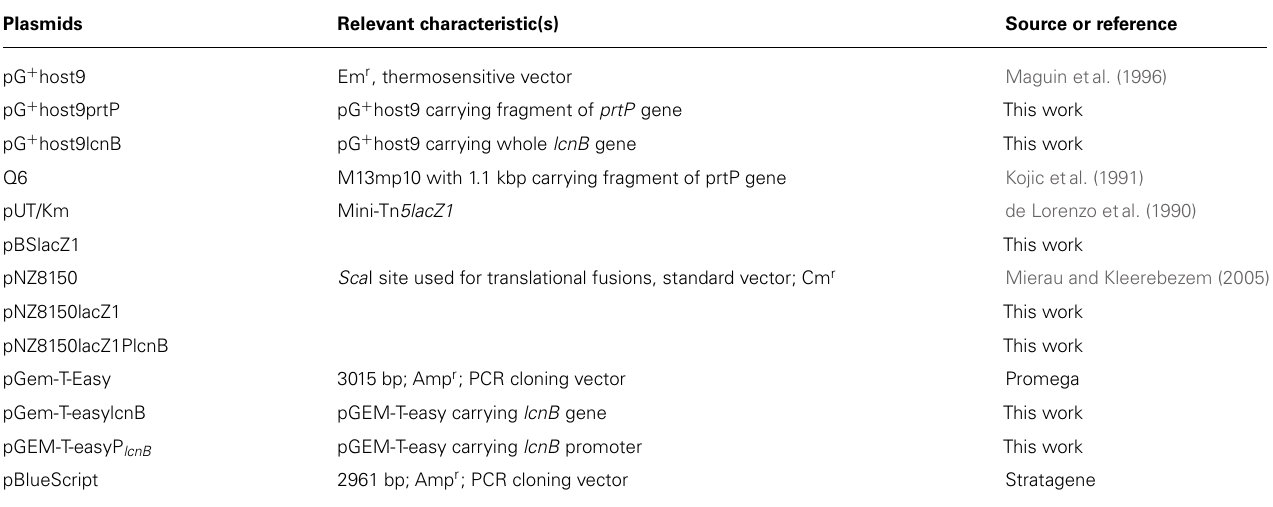
Table 2 | Plasmids used in this